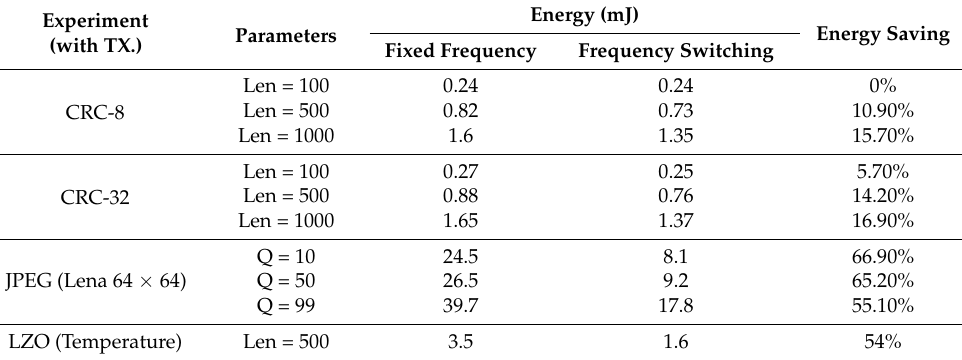
Table 2. Comparative summary of energy consumption for fixed frequency and switched frequency. Experiment (with TX.)